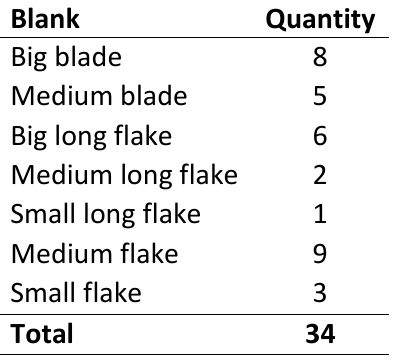
Table 5. Type-blank A rectangular blanks with one cutting edge opposed to a backed side.